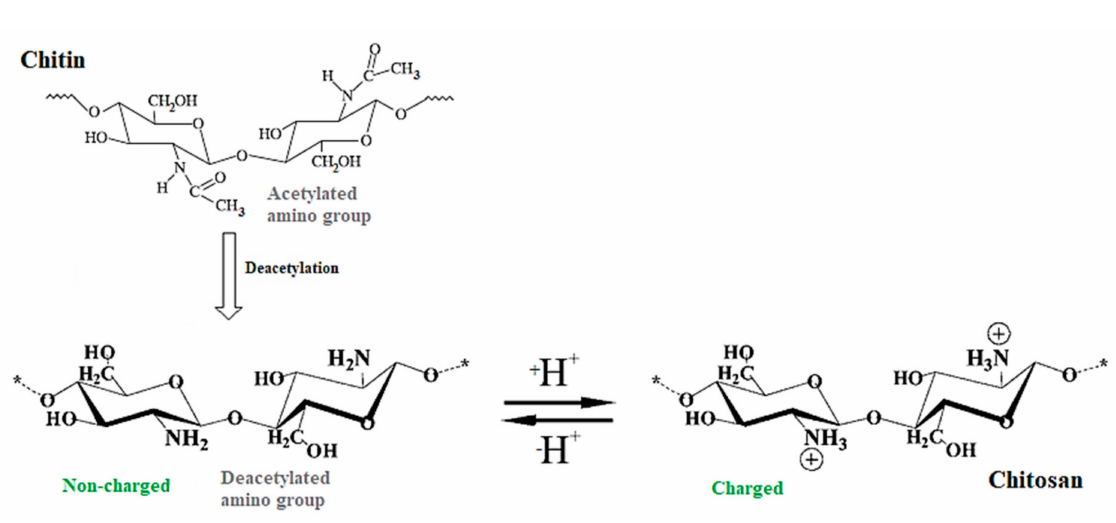
Figure 2. Chemical structures of chitin and